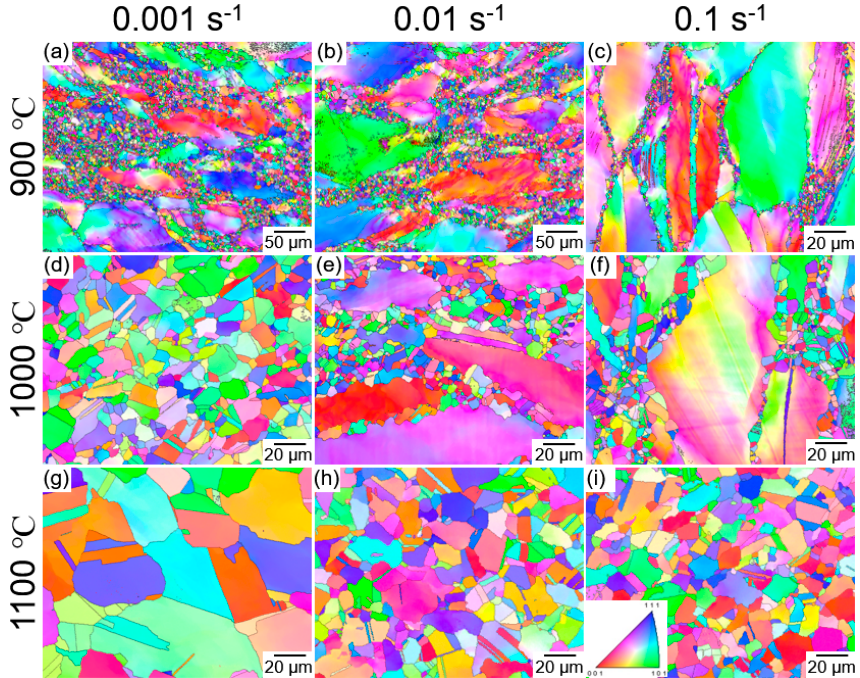
Figure 9. EBSD IQ maps of the (CoCrNi) 94 Ti 3 Al 3 alloy hot-compressed at ( a–c ) 900 °C, ( d–f ) 1000 °C, and ( g–i ) 1100 °C with a strain rate of ( a,d,g ) 0.001 s − 1 , ( b,e,h ) 0.01 s − 1 , and ( c,f,i ) 0.1 s − 1 , respectively. and ( g – i ) 1100 ◦ C with a strain rate of ( a , d , g ) 0.001 s − 1 , ( b , e , h ) 0.01 s − 1 , and ( c , f , i ) 0.1 s − 1 ,